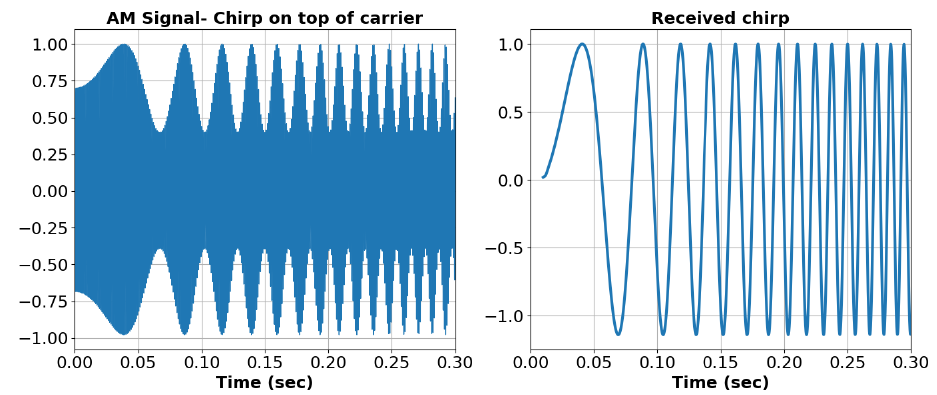
Figure 7. AM Chirp ( left ) and reconstructed chirp ( right